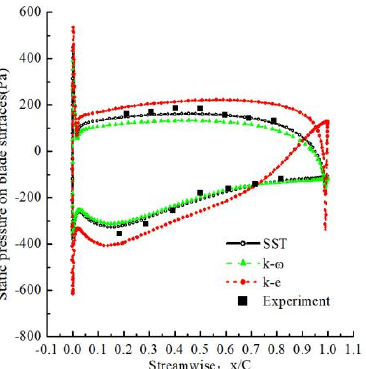
Figure 3. Predicted and experimental static pressure on blade surfaces for different turbulence